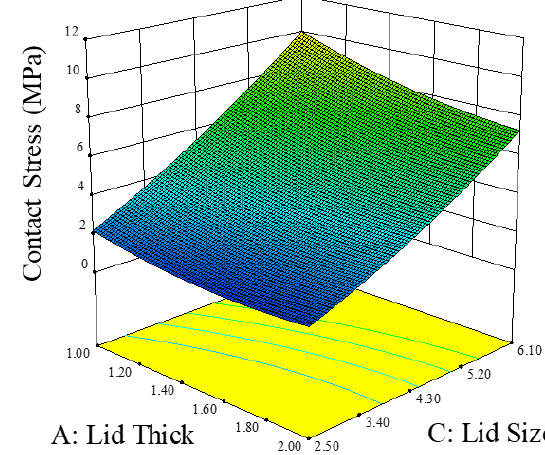
Figure 14. The response surface results for discussing the relationship between the lid thickness and the lid size.